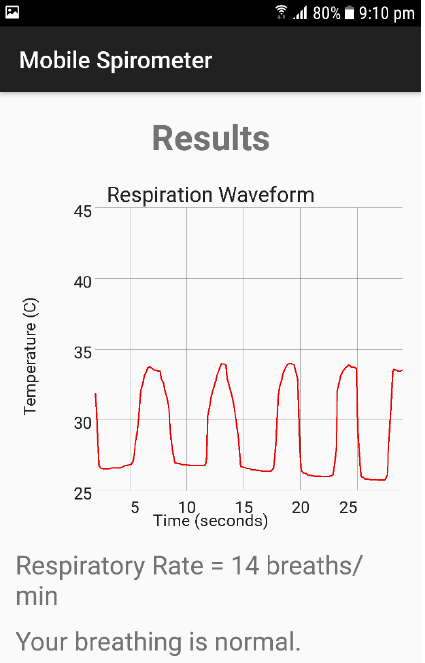
Figure 7. The interface of the mobile application for respiration rate